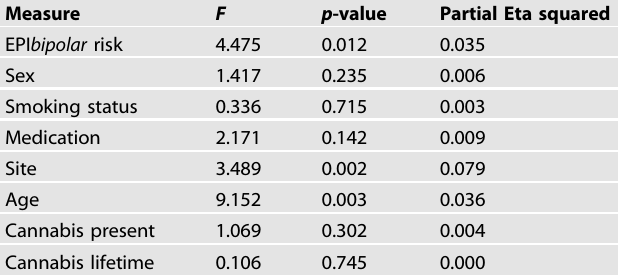
Table 2. Results of the generalized linear models using the thickness of the left pars opercularis as an independent variable.